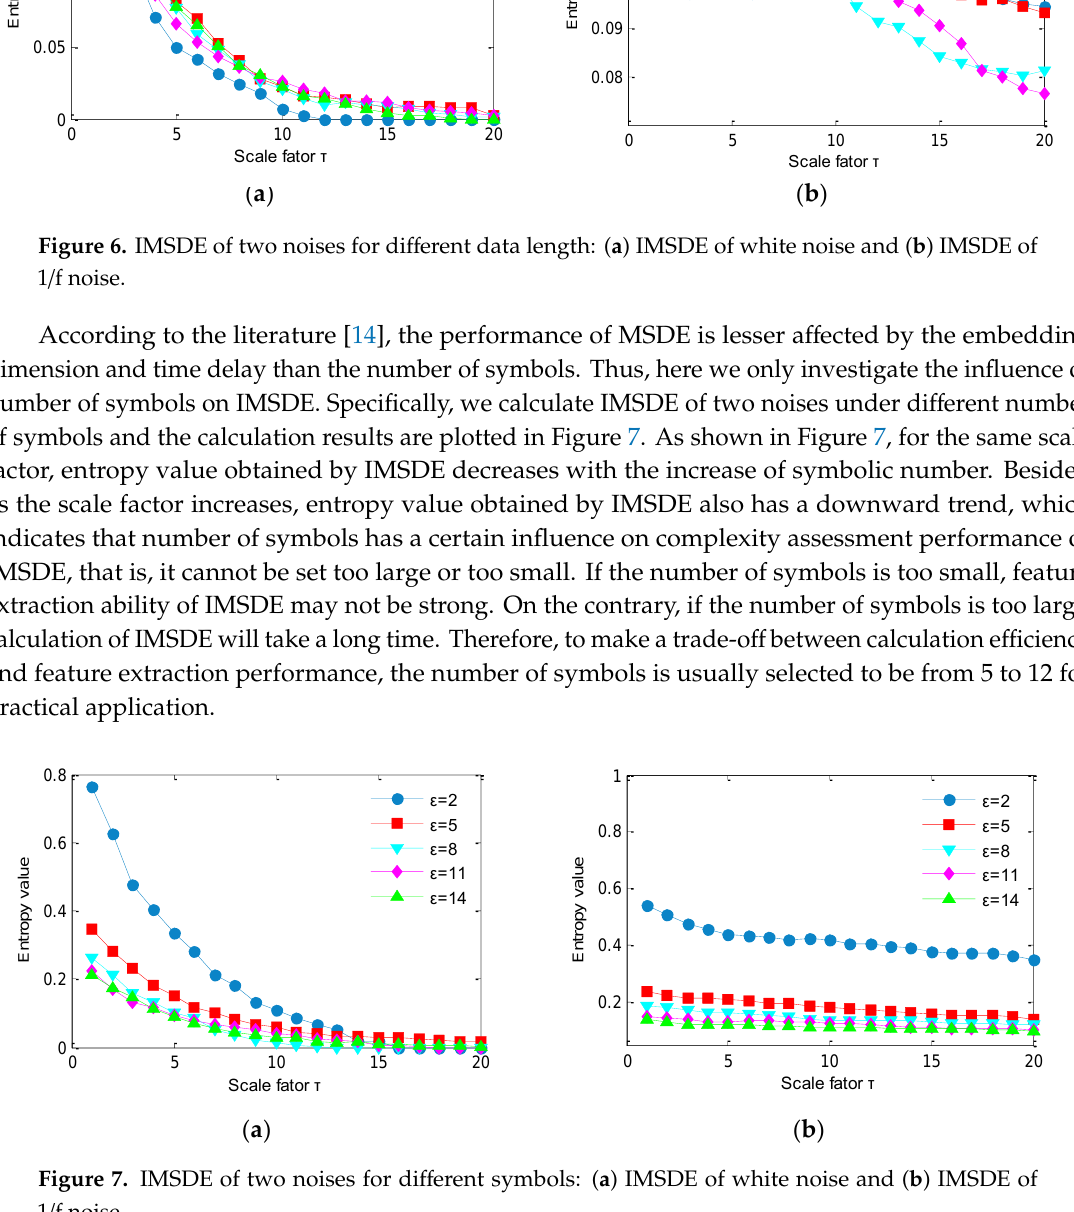
Figure 7. IMSDE of two noises for different symbols: ( a ) IMSDE of white noise and ( b ) IMSDE of 1/f noise.